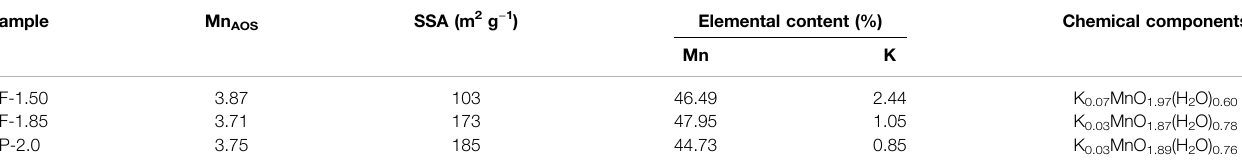
TABLE 1 | Chemical components, AOS and SSA of manganese oxide samples prepared using reaction mixtures of varying KMnO 4 /H 2 O 2 ratios.